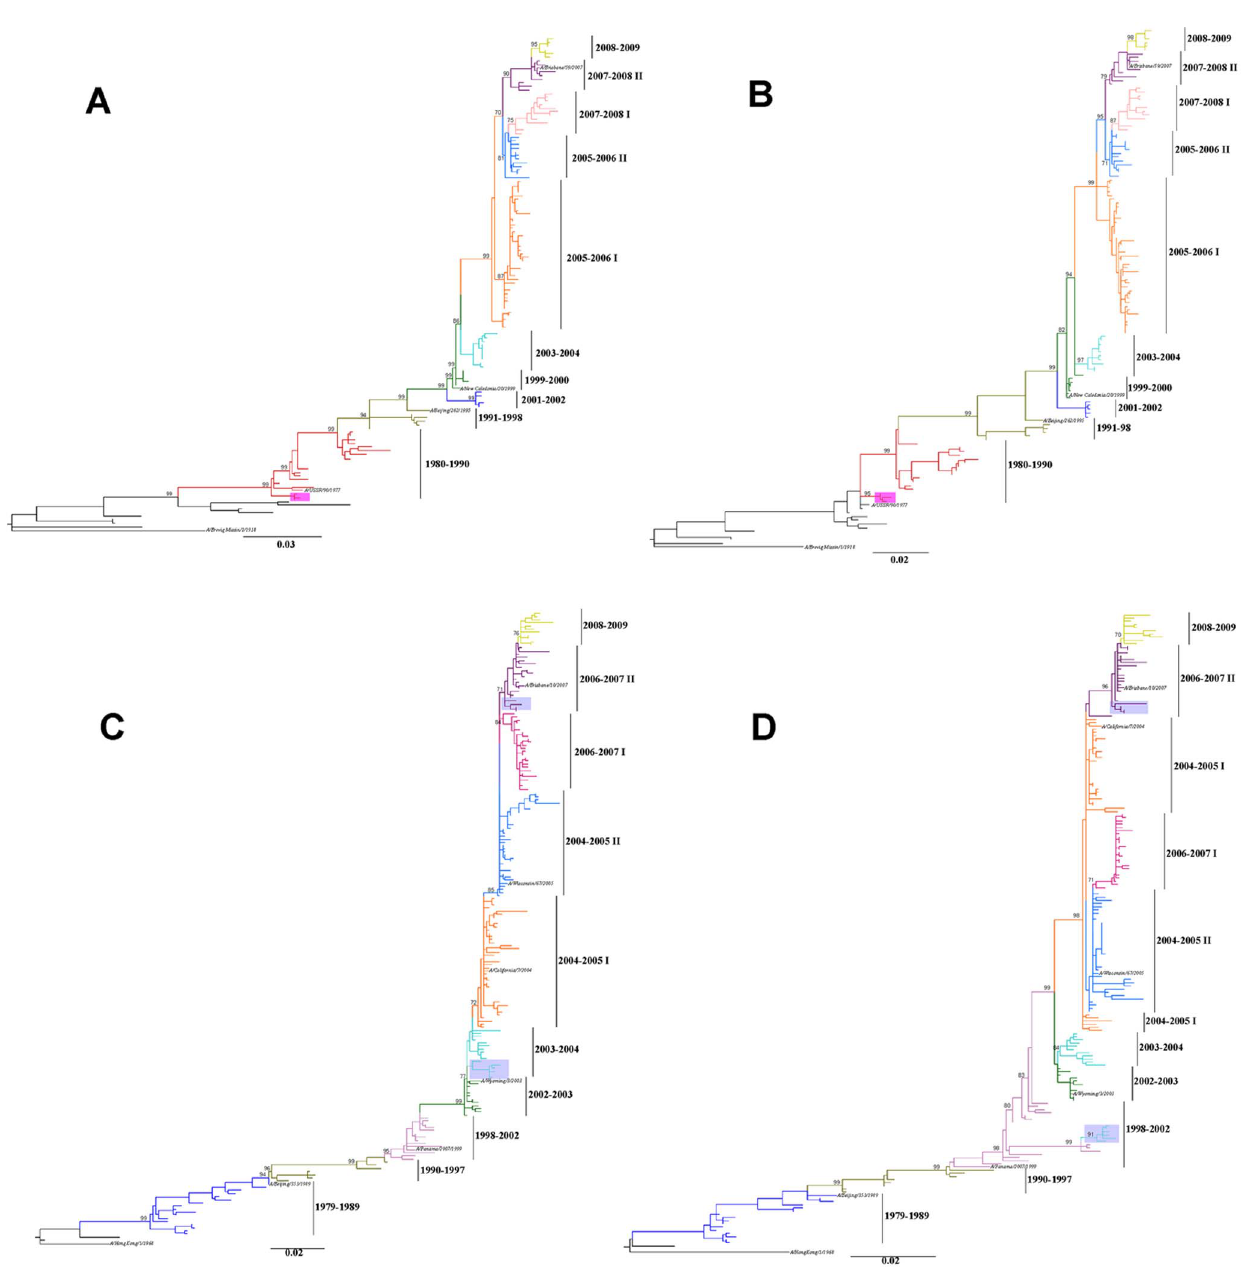
Figure 1. Phylogenetic relationships of the HA and NA gene segments of influenza A viruses in Taiwan. Phylogenetic relationships of the (A) HA gene segment of H1N1 (B) NA gene segment of H1N1 (C) HA gene segment of H3N2 (D) NA gene segment of H3N2 influenza A viruses sampled from Taiwan during 1979–2009, estimated using ML method. The trees were rooted on the oldest isolate (A/Brevig Mission/1/1918 for H1N1 and A/Hong Kong 1/1/1968 for H3N2). Colored branches represent different lineages of related influenza seasons that are present in the inferred genealogies of all eight viral genome segments (Figure S2A–2F). Bootstrap values (1000 replicates) . 70% are shown for key nodes. For H1N1 viruses (panel A and B), 1980–1990 isolates are colored red, 1991–1998 isolates are chartreuse, 1999–2000 isolates are green, 2001–2002 isolates are indigo, 2003–2004 isolates are light blue, 2005–2006 I isolates are orange, 2005–2006 II isolates are sky blue, 2007–2008 I isolates are pink, 2007–2008 II isolates are purple, and 2008–2009 isolates are light green. For H3N2 viruses (panel D and C): 1979–1989 isolates are cyan, 1990–1997 isolates are chartreuse, 1998–2002 isolates are pink, 2002–2003 isolates are green, 2003–2004 isolates are light blue, 2004–2005 I isolates are orange, 2004–2005 II isolates are sky blue, 2006–2007 I isolates are violet, 2006–2007 II isolates are purple, and 2008–2009 isolates are light green. Pink solid rectangle indicates 1980 H1N1 reassortant viruses, and grey solid rectangle indicates 2004 H3N2 reassortant viruses. Vaccine strains are highlighted in Italic